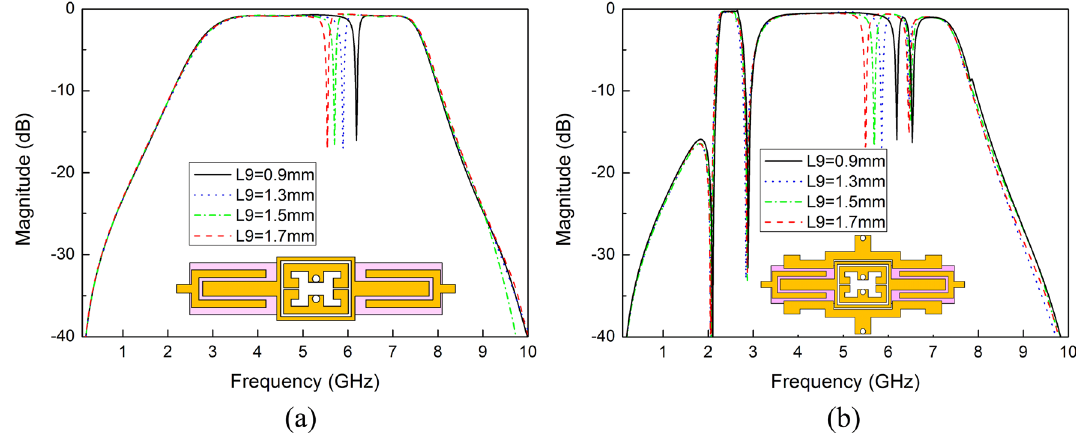
Figure 13. The variable second notch frequency corresponding to different length L9 ( a ) without and ( b ) with SSLSIR type2 loaded on the filter.